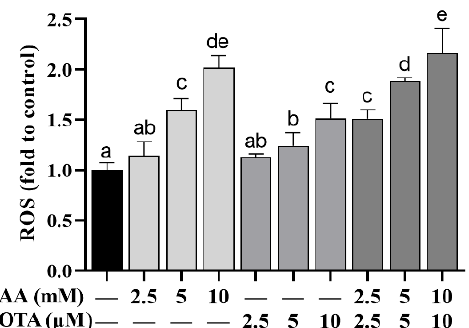
Figure 5. Effect of AA and OTA on ROS production. a – e Different letters indicate significant differ- ences, p < 0.05.